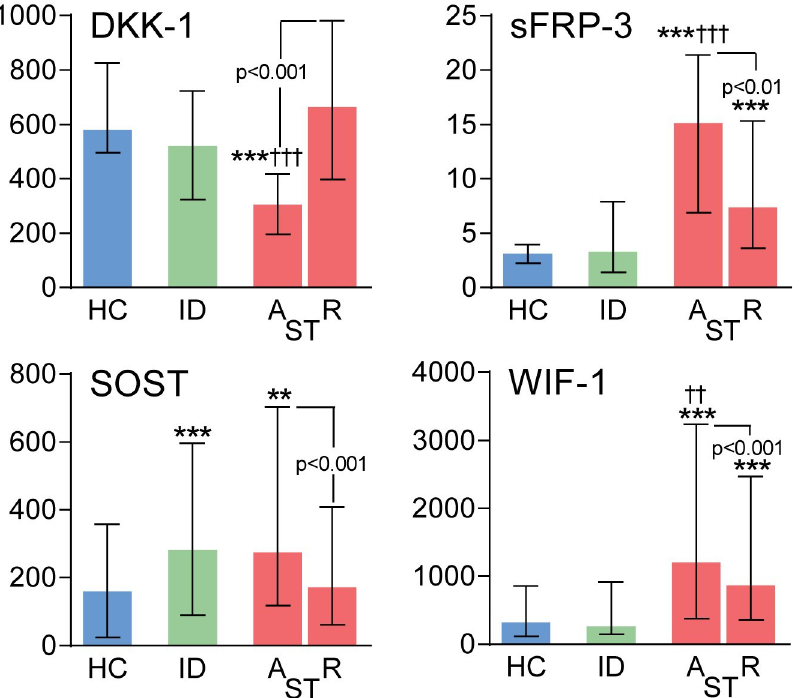
Fig 1. Plasma levels of secreted Wnt antagonists in scrub typhus patients and healthy controls. Levels of Dickopff- 1 (DKK-1), secreted frizzled related protein-3 (sFRP-3), sclerostin (SOST) and Wnt inhibitory factor (WIF-1) in scrub typhus patients (n = 129) on admission (A) and at recovery (R) as well as comparative levels in healthy controls (HC, n = 31) and infectious disease controls (ID, n = 31). Data are given as medians and 25th, 75th percentiles. � p < 0.05, �� p < 0.01 and ��� p < 0.001 versus healthy controls; †† p < 0.01 and ††† p < 0.001 versus infectious disease controls. Comparisons between levels at admission and recovery are also shown with p-values.